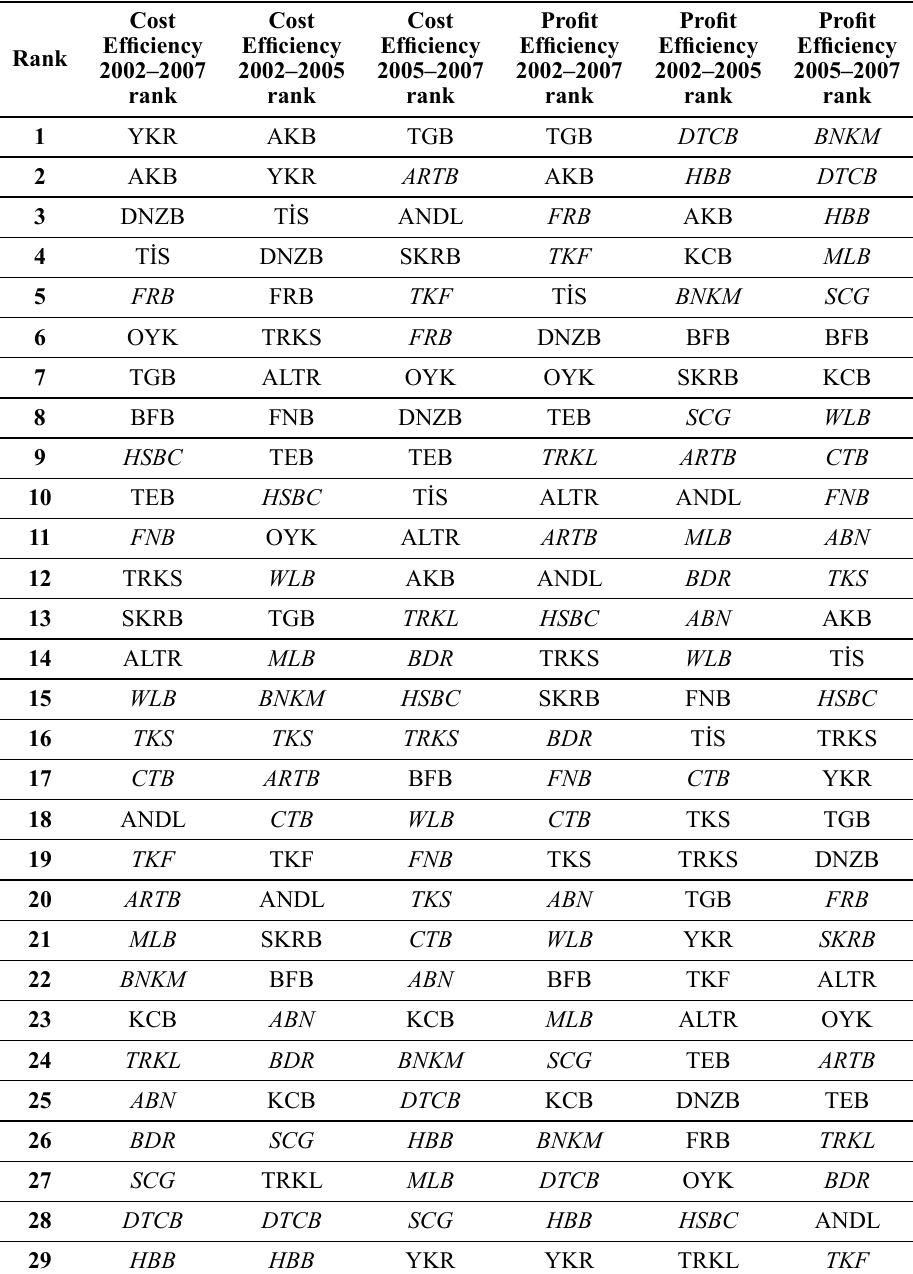
Table A.7. Efficiency Ranks of the Banks Excluding State